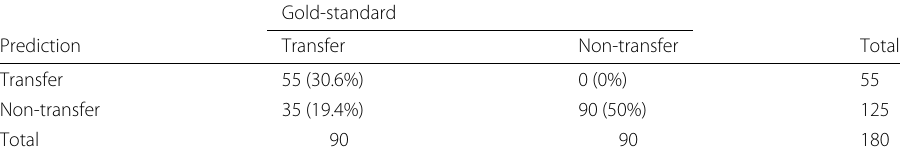
Table 5 Confusion matrix of text similarity comparing (cosine similarity) Gold-standard Prediction Transfer Non-transfer Transfer Total 180